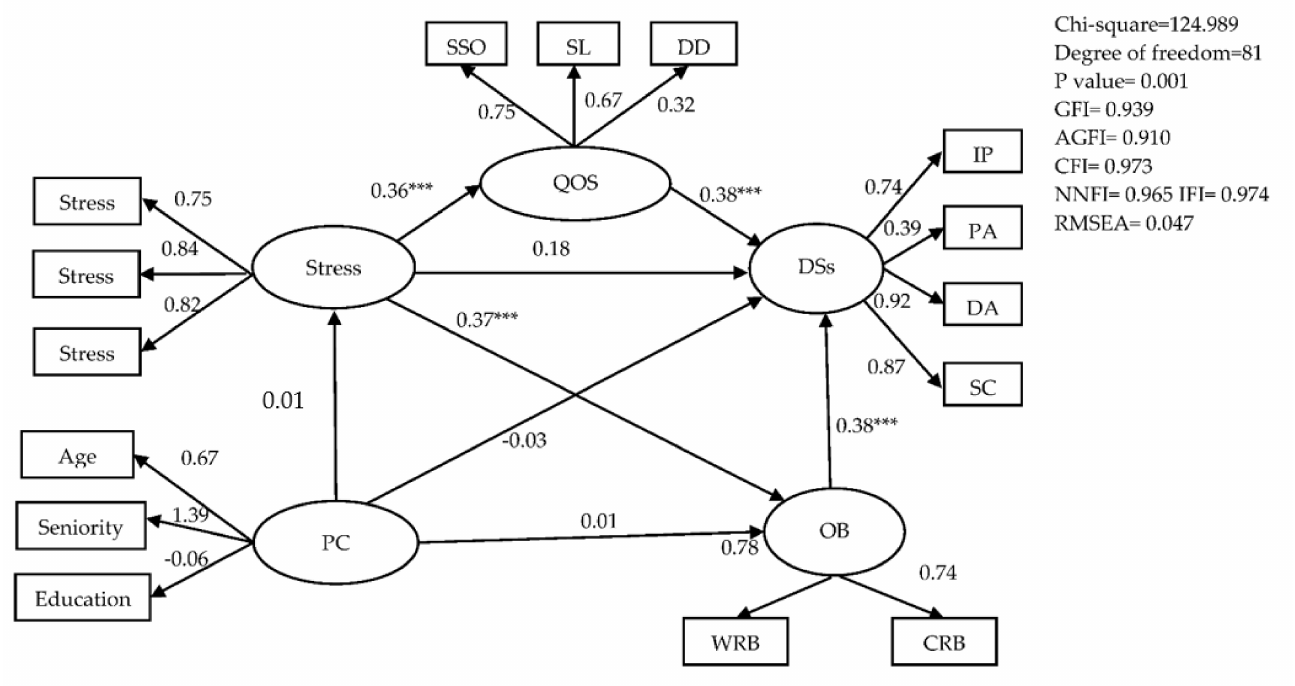
Figure 2. Conceptual framework of hypothesized model. Note. Personal characteristics = PC; quality of sleep = QOS; Depressive symptoms = DSs; occupational burnout = OB; subjective sleep quality = SSQ; sleep latency = SL; sleep efficiency = SE; daytime dysfunction = DD; interpersonal problems = IP; positive affect = PA; depressed affect = DA; somatic complaints = SC; personal burnout: PB; work-related burnout = WRB; client-related burnout = CRB; over-commitment to work = OCTW; = latent variable; = measured variable; → = unidirectional path; *** = p <